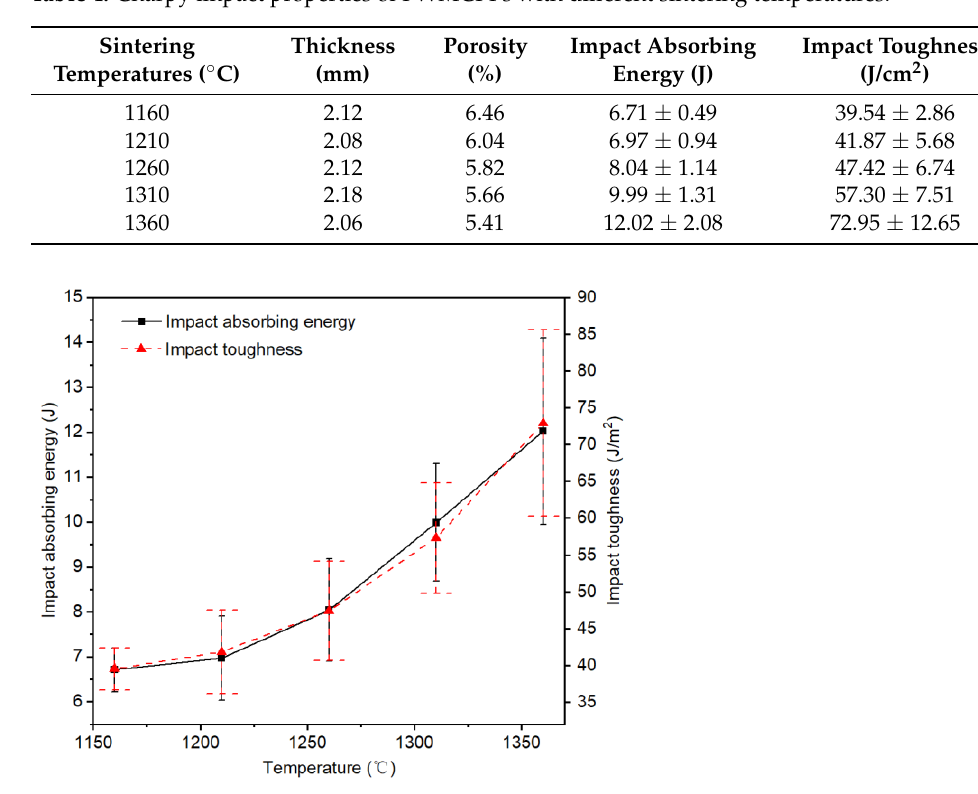
Table 4. Charpy impact properties of PWMCPPs with different sintering temperatures.